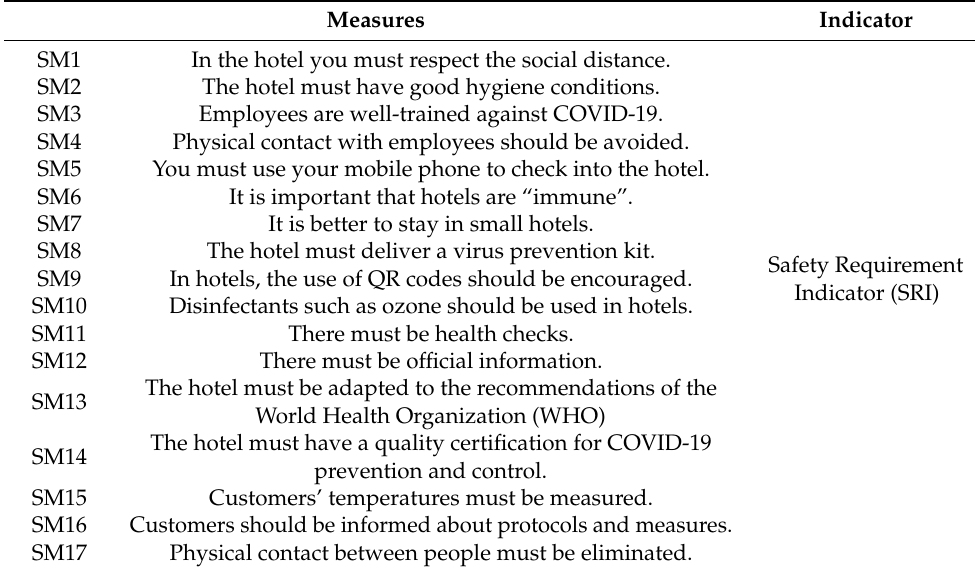
Table 2. Security measures and indicator.